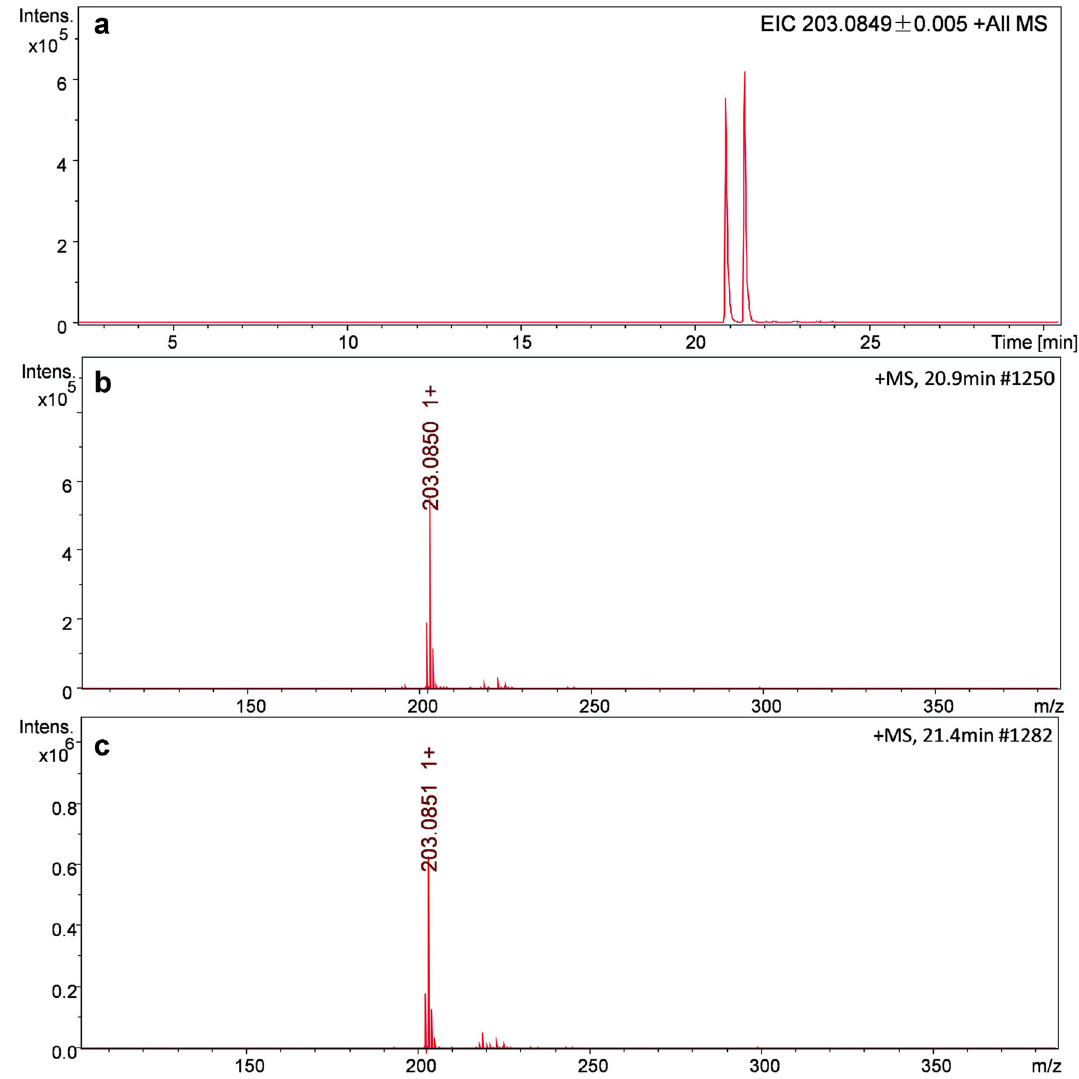
Fig. 5 EIC ( a ) and mass spectra ( b and c ) of isomers of [C 11 H 11 N 2 O 2 ] ? ( m / z = 203.0849) detected by